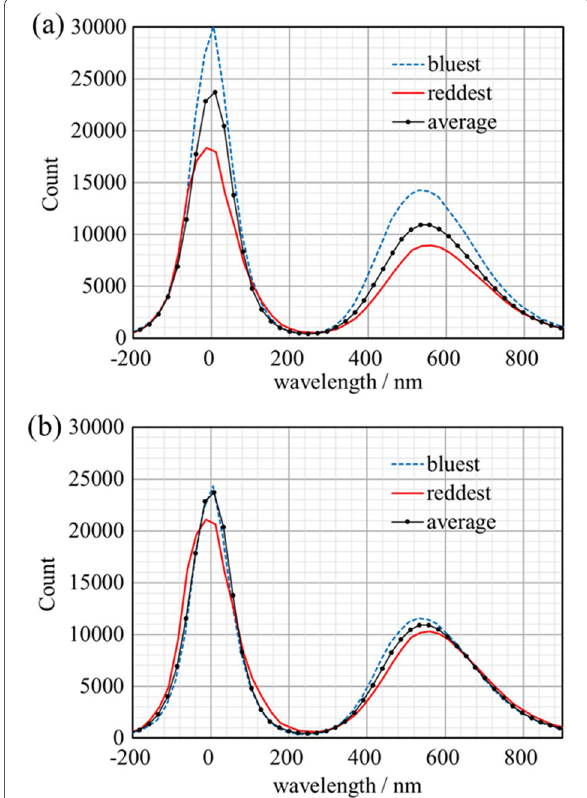
Fig. 17 The effect of atmospheric scintillation on a spectrum of β Cet (Diphda). We recorded one hundred successive video frames with both the exposure time and frame interval of 20 ms and obtained count profiles along the zero-order and spectral images. a The broken blue line shows the profile for a frame when the star appears bluest in the one hundred frames. The solid red line shows the profile when the star appears reddest. The thin black line shows the average count profile over the one hundred frames. The plots along the average profile correspond to horizontal pixel positions in the averaged image (Fig. 10a). b The counts (y-axis values) were corrected as the total count is the same as that of the average profile to show the difference in the spectral waveform